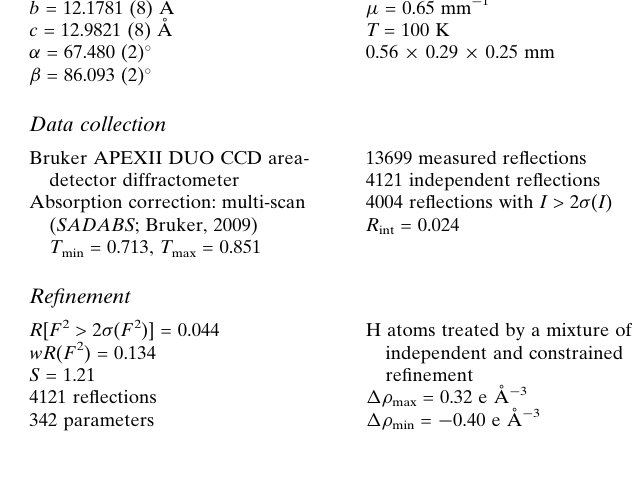
Hydrogen-bond geometry (A ˚ , (cid:2)